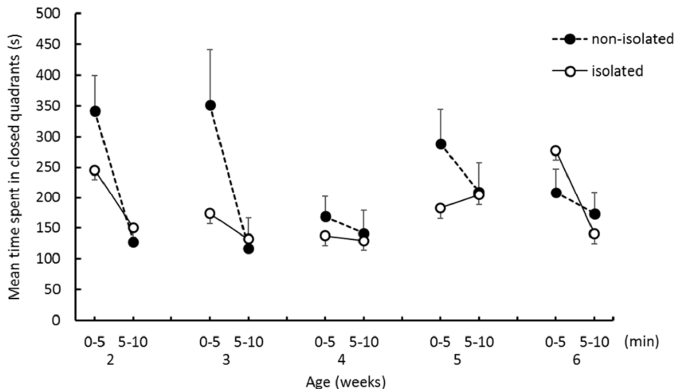
Figure 3. The mean time spent in the closed quadrants during the EZM test. Error bars indicate the standard error.